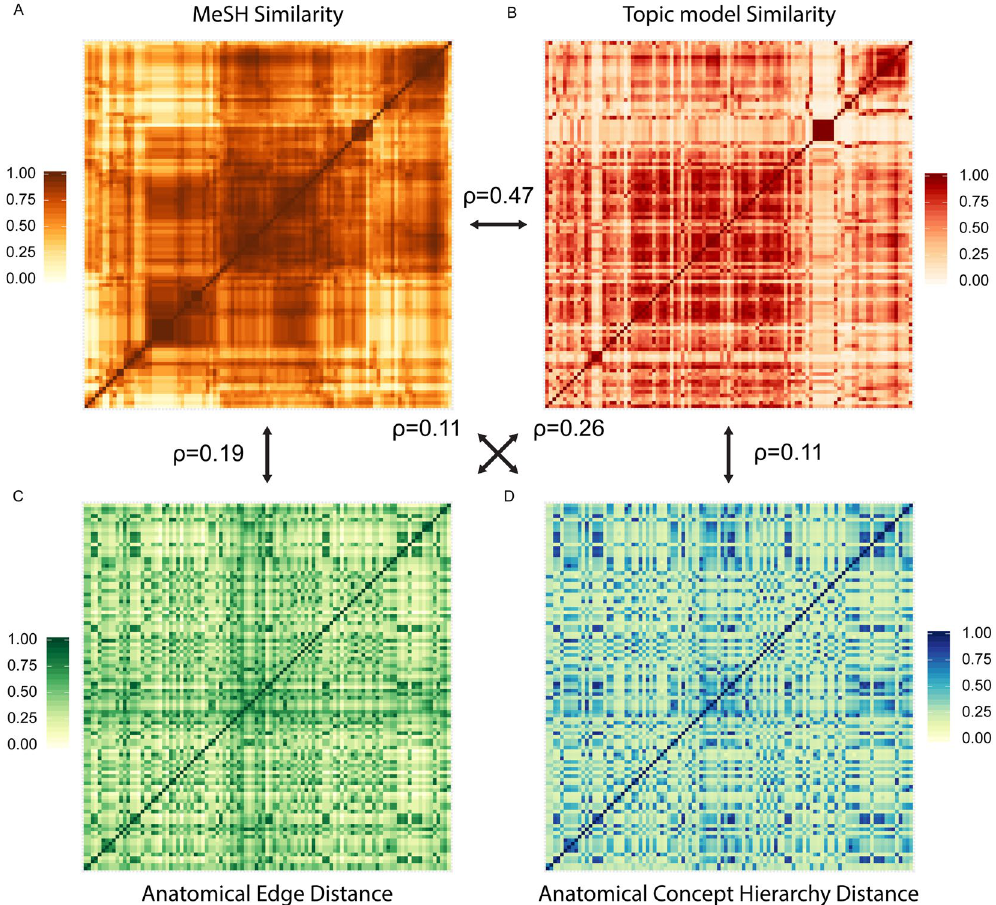
Figure 4. The similarity matrices for the 103 structures that had at least one psychological phenomenon or process associated with it. ( A ) The MeSH functional similarity matrix. ( B ) The Topic modeling functional similarity matrix. ( C ) The anatomical similarity matrix as defined by the edge distance. ( D ) The anatomical similarity matrix as defined by the concept hierarchy distance. The MeSH similarity matrix (panel A) is organized using a hierarchical clustering algorithm to optimize the visualization of the internal block structure. The other three matrices in panel (B–D) have been reorganized to have the identical organization as the MeSH similarity matrix. The arrows and corresponding ρ values indicate the correlation between the different